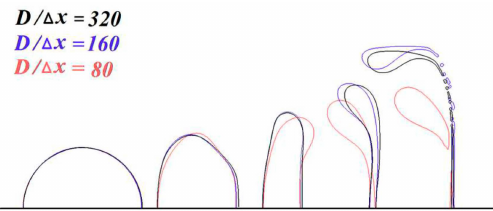
Figure 5. Resolution test with di ff erent grids.